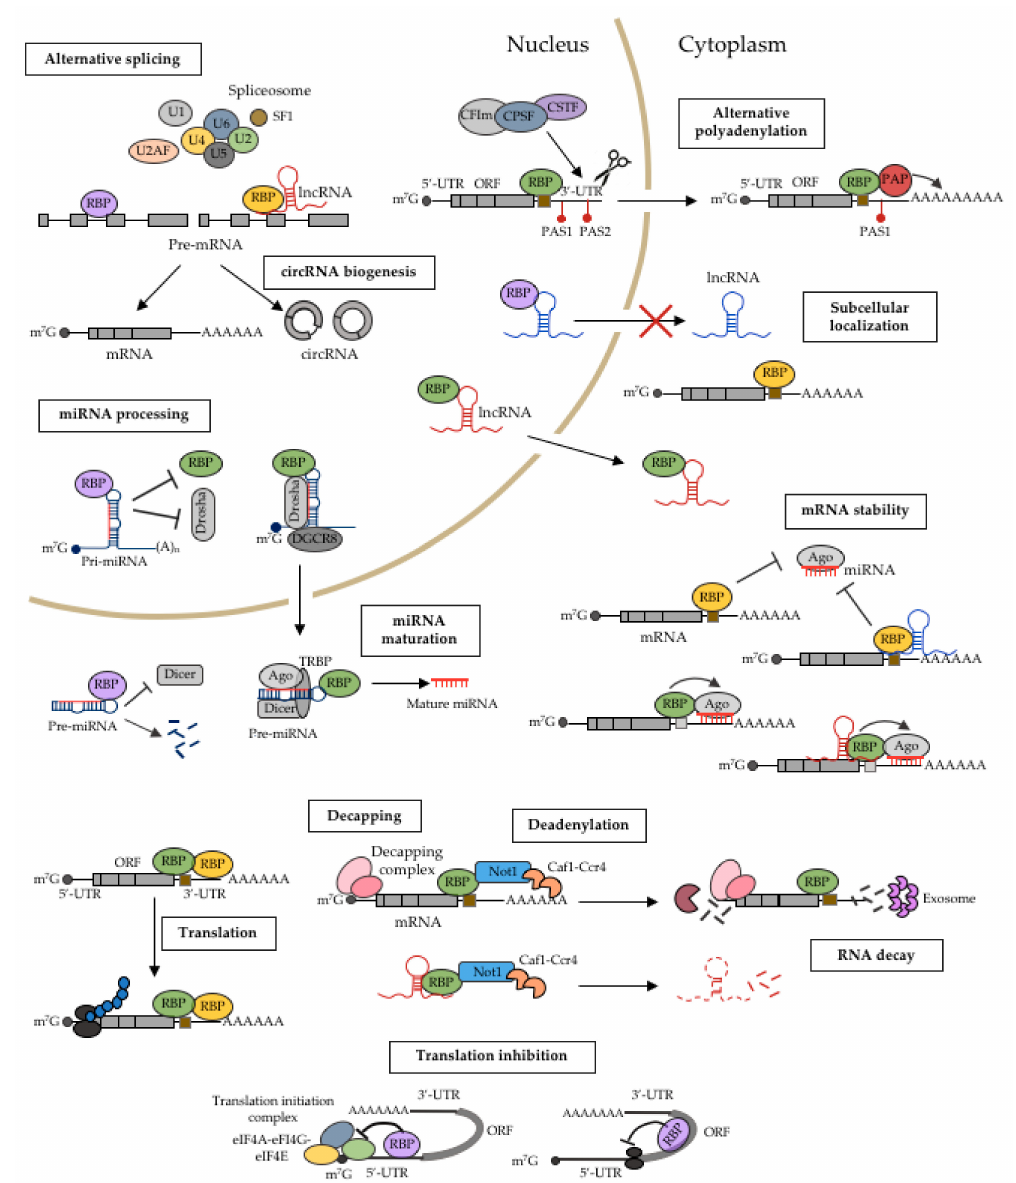
Figure 1. Mechanistic roles of RBPs in the posttranscriptional regulation of gene expression in cancer. RBPs are key regulators of gene expression at the post-transcriptional level. They can determine the fate of an RNA by regulating various events, including their miRNA-mediated processing, alternative splicing, alternative polyadenylation, subcellular localization, stability, and translation. Schematic diagrams of the functions of RBPs in these mechanisms are